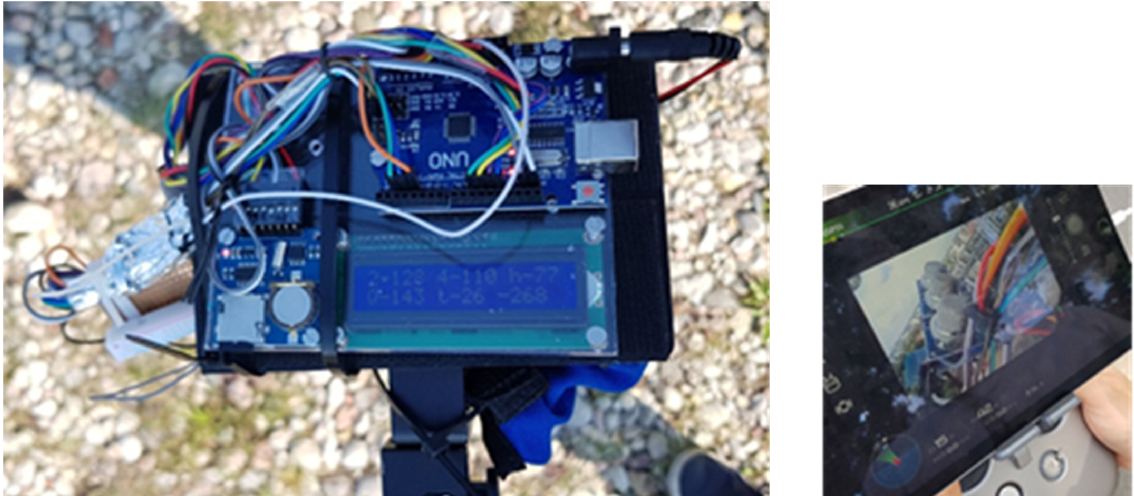
Figure 1. A device for measuring gas concentration in a landfill site.